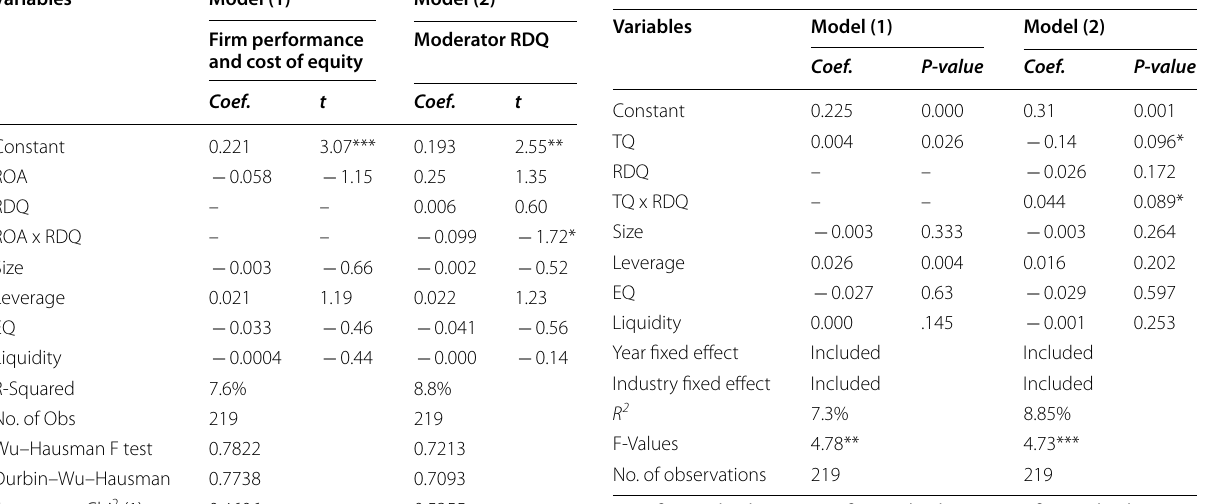
Table 8 Robustness test of using Tobin’s Q to proxy the firm performance in the regression